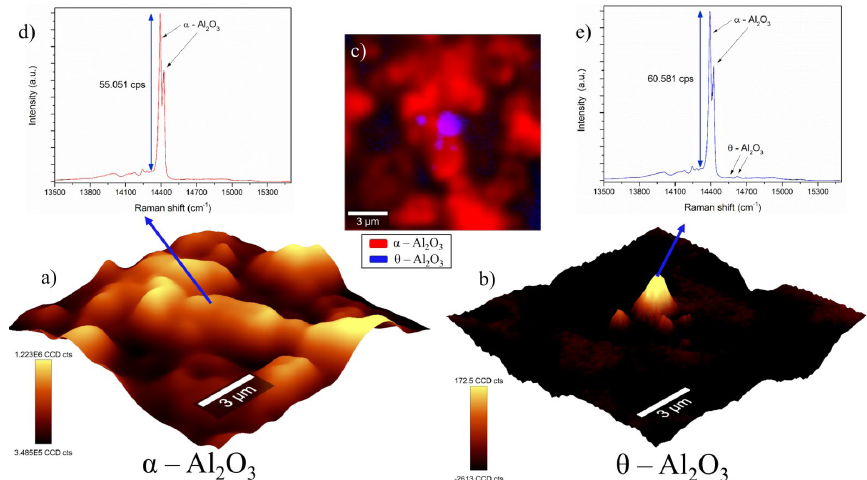
Figure 7. Confocal Raman mapping at the surface of the unmodified aluminized coating after isothermal oxidation at 1000 °C for 200 h: a) mapping in a spectral range from 14,308 to 14,472 cm -1 (α-Al c) mapping showing the distribution of polymorphic forms of Al